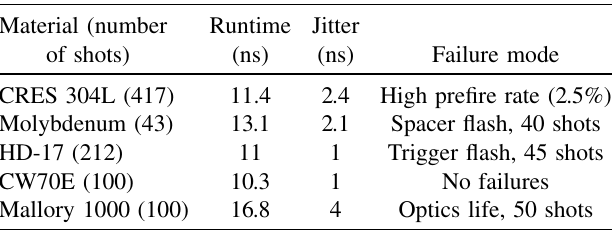
DEVELOPMENT OF A 5.4 MV LASER TRIGGERED GAS . . TABLE IV. Trigger runtime and jitter as a function of trigger electrode material.